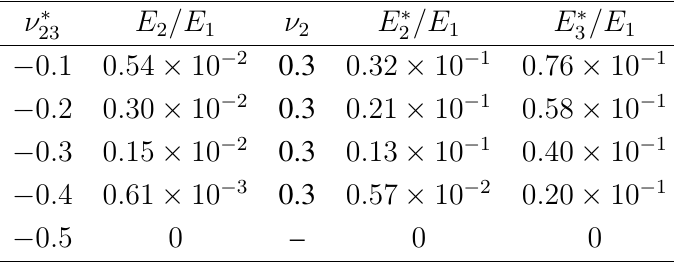
Table 1. For a required negative value of ν ∗ array θ = 45 ◦ of Figure 2 and the resulting effective transverse